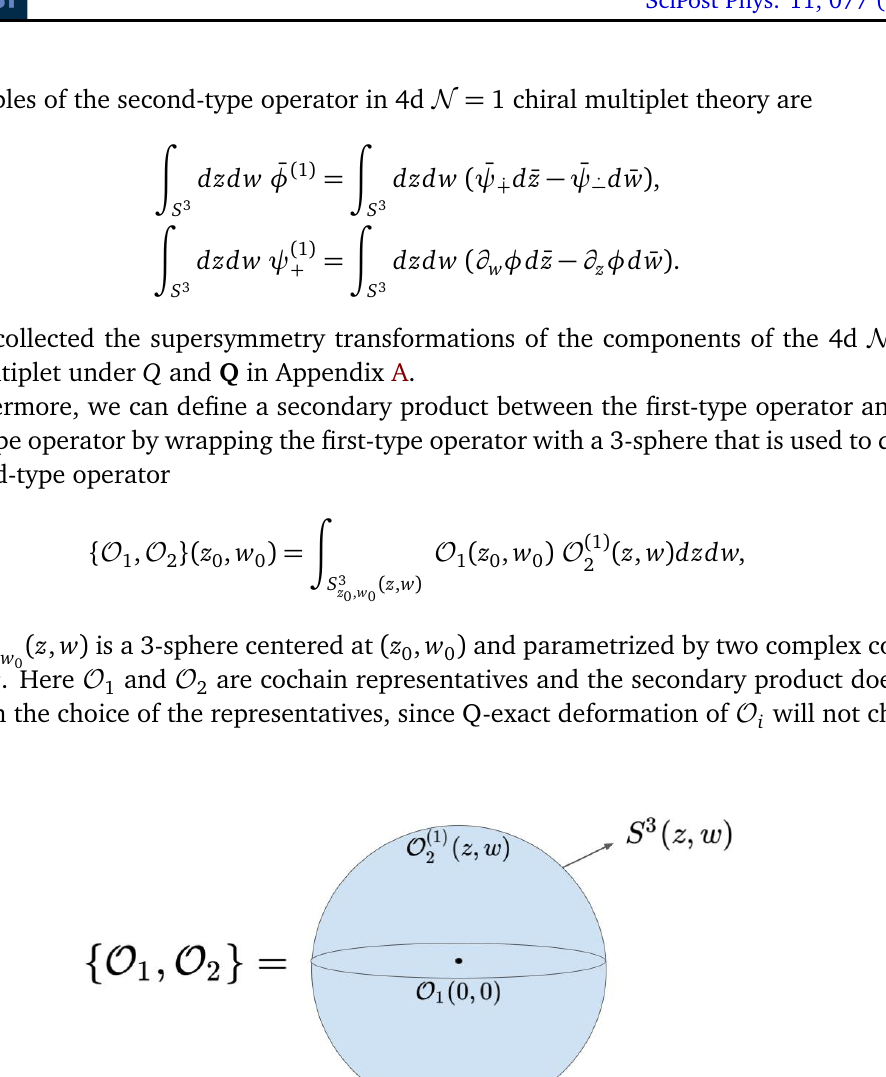
( 1 ) , which is supported on the 3-sphere 2